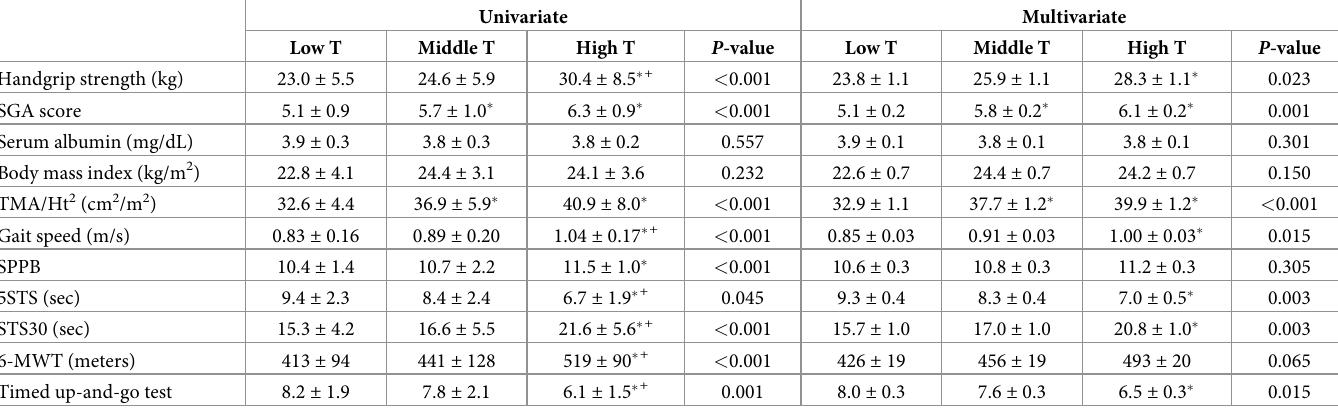
phase angle as a continuous variable was associated with HGS, SGA score, TMA/Ht 2 , GS, SPPB, 5STS, STS30, 6-MWT, and TUG (Table 3). The correlation coefficients between the phase angle and TMA/Ht 2 , HGS, and GS were 0.517, 0.485, and 0.463, respectively (Fig 1). No Table 2. Comparison of muscle mass indices, nutritional markers, and physical activity markers according to the tertiles of phase